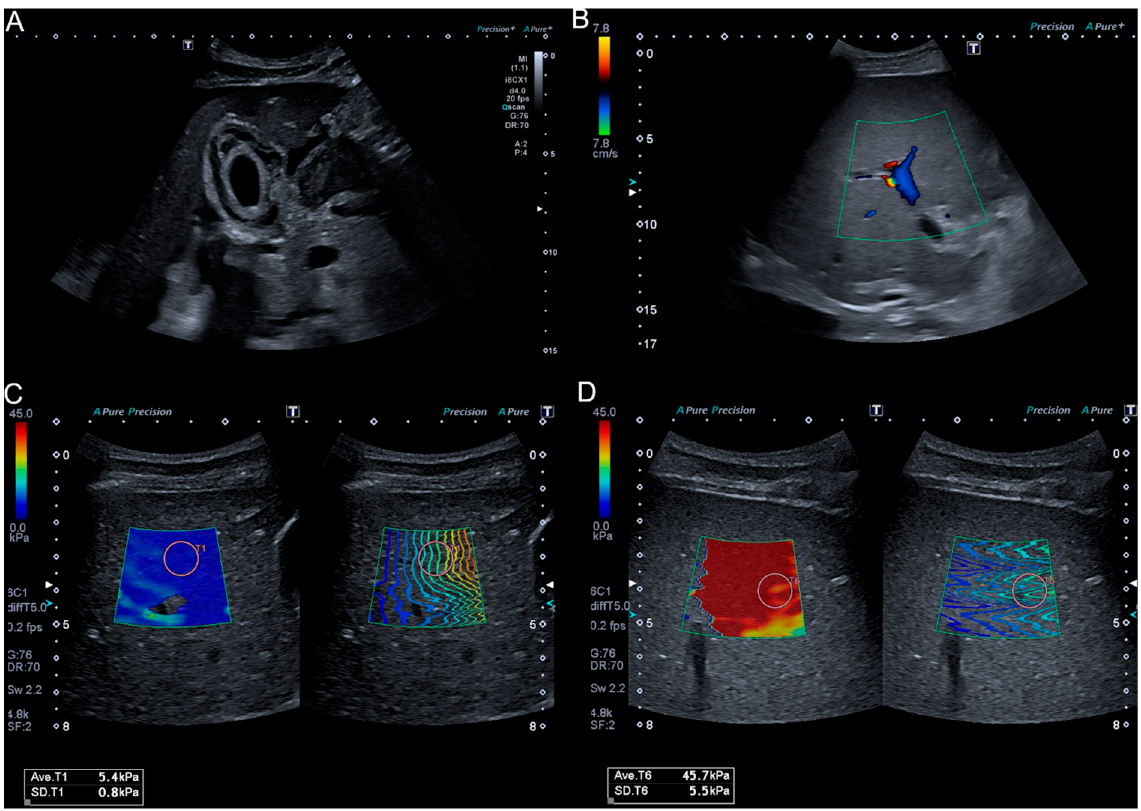
Figure 1. US imaging and SWE in a 36-year-old SOS/VOD patient. Gallbladder wall-thickening ( A ); reversed portal vein flow in color Doppler ultrasound ( B ); 2D-SWE before HSCT ( C ); and after development of SOS/VOD after HSCT ( D ).